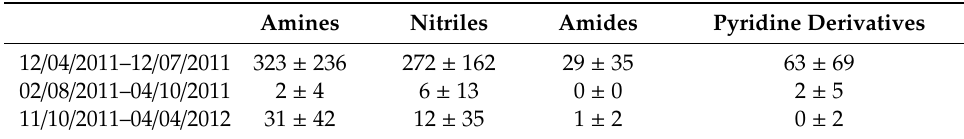
(cid:80) Table A1. Average NRRFs of amines, nitriles, amides and pyridine derivatives measured during the three di ff erent periods indicated by Booyens et al. [30] for all polar organic compounds.